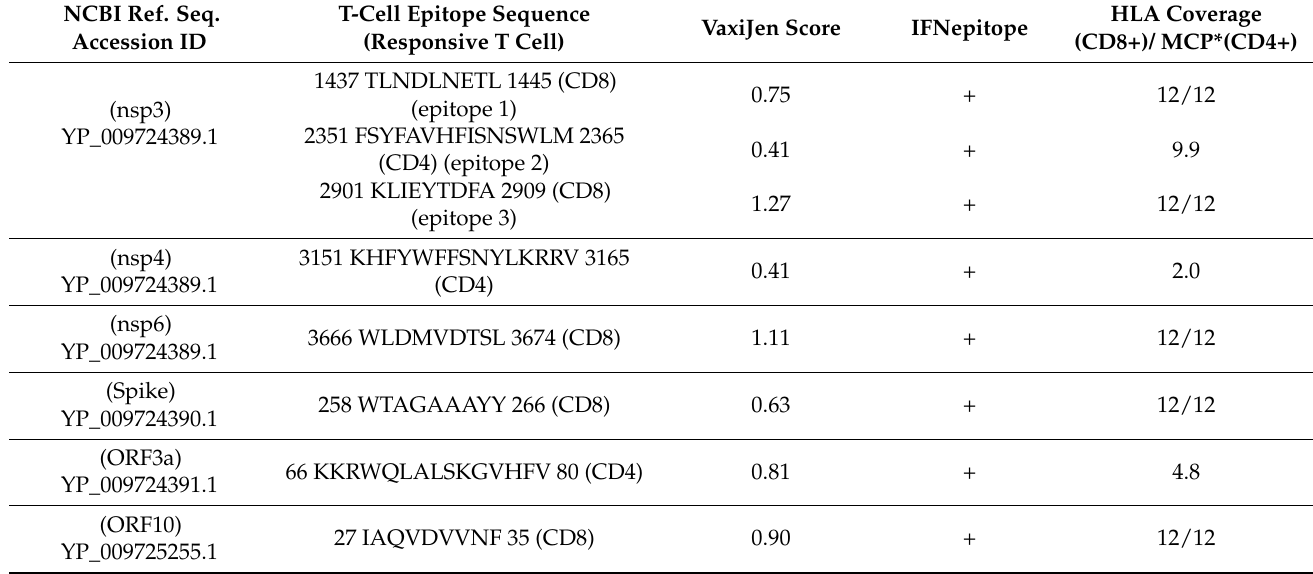
Table 4. T-cell epitopes of SARS-CoV-2 and their corresponding antigenicity scores, IFN- γ induction, and HLA coverage (CD8+) and/or MCP (CD4+). NCBI Ref.